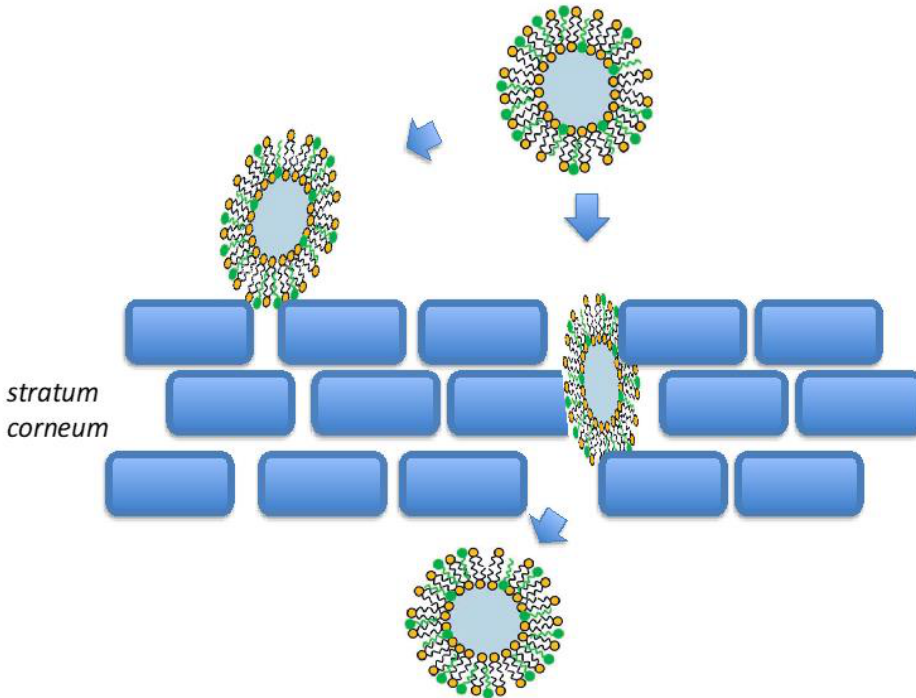
Figure 3. Schematic representation of transfersome penetration through the